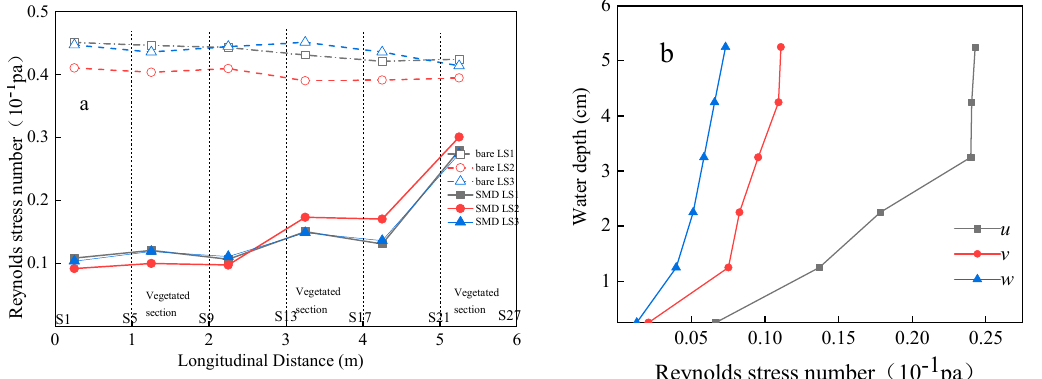
Figure 10. ( a ) Longitudinal variation of RSN values for the vegetated SMD arrangement slope and bare slope. ( b ) Relationship between the water depth and RSN s in different directions.